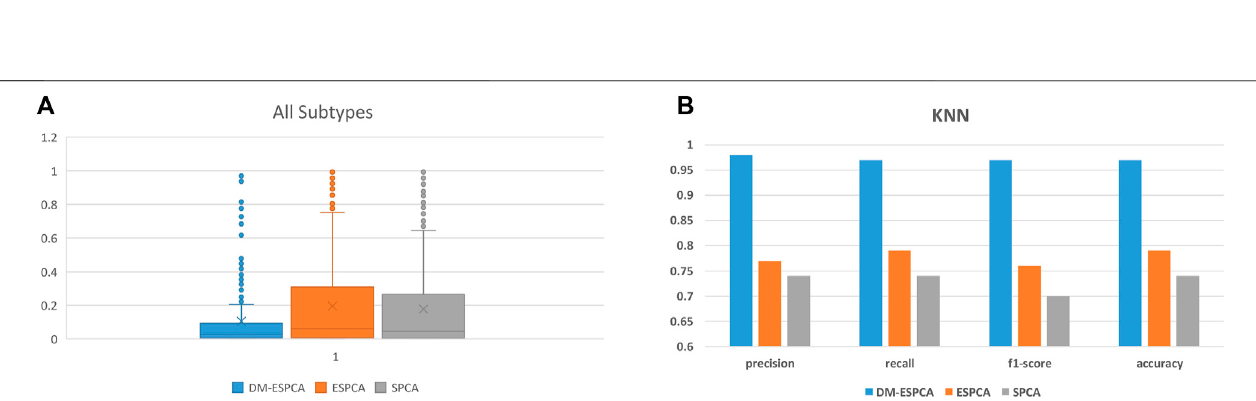
FIGURE 7 | Boxplots and classi fi cation comprehensive indicators of the BCI data set; (A) p -values of selected genes in all subtypes. (B) Results of KNN in three sparse PCA methods and the use of all